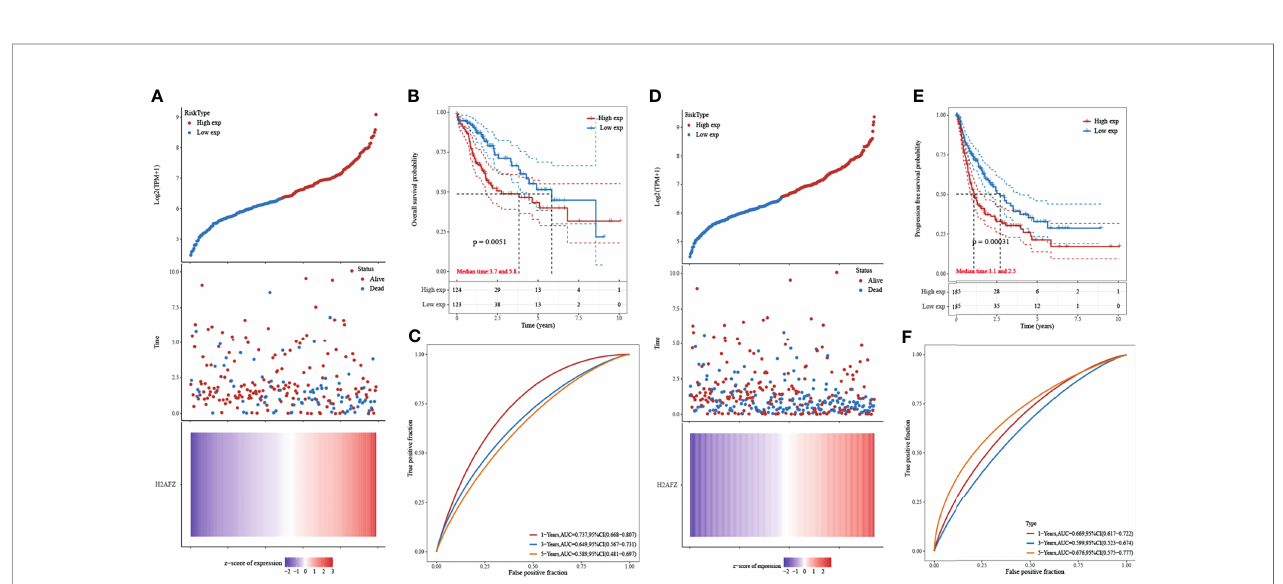
FIGURE 3 | Prognostic analysis of H2AFZ in the TCGA-LIHC cohort. (A) The curve of risk score; the dotted line represented the median risk score and divided the patients into low-risk and high-risk group. Overall survival (OS) status of the patients; more dead patients corresponding to the higher risk score. Heatmap of the expression pro fi les of H2AFZ in the low- and high-risk group. (B) Kaplan – Meier overall survival analysis of H2AFZ in the TCGA-LIHC cohort. (C) Time-dependent ROC curves of OS of H2AFZ in the TCGA-LIHC cohort. (D) The curve of risk score. Progression-free survival (PFS) status of the patients. Heatmap of the expression pro fi les of H2AFZ in the low- and high-risk group. (E) Kaplan – Meier progression-free survival analysis of H2AFZ in the TCGA-LIHC cohort. (F) Time-dependent ROC curves of PFS of H2AFZ in the TCGA-LIHC